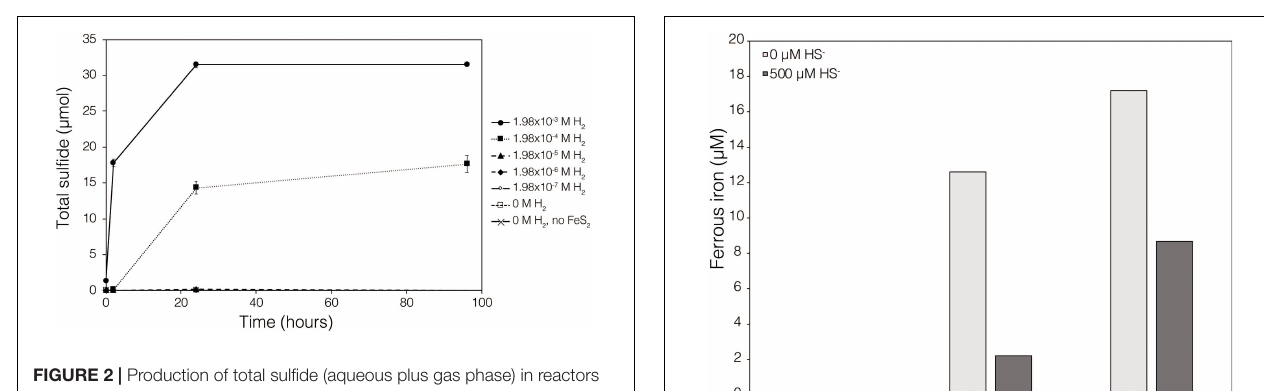
FIGURE 2 | Production of total sulfide (aqueous plus gas phase) in reactors containing 2 mM synthetic FeS 2 nanoparticles when incubated at 38 ◦ C in the presence of H 2 ranging from 0 to 1.98 × 10 - 3 M aqueous H 2 (equivalent to 0 to 2.5 bar). All abiotic reactors contained 35 mL of base salts medium and 35 mL of headspace (balance of headspace as N 2 gas). FIGURE 3 | Dissolved ferrous iron [Fe(II)] concentration in abiotic dialysis